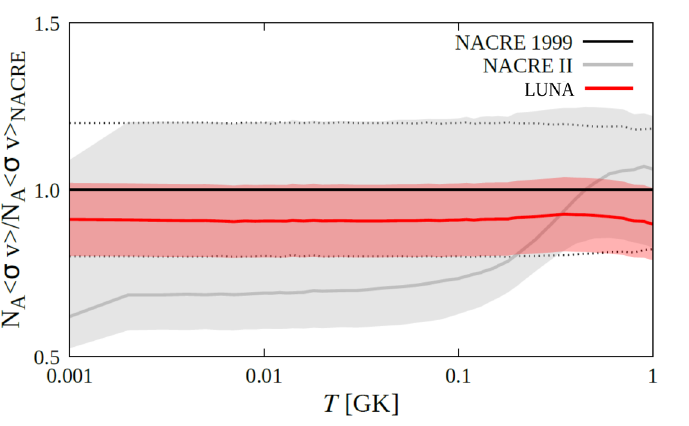
Figure 3: Reaction rate for the 6 Li( p , γ ) 7 Be reaction, normalized to the NACRE rate [24]. The NACRE II rate [16] is also shown for comparison. Dashed lines represent the uncertainty on the NACRE rate, while shaded areas represent the uncertainties from LUNA experiment (red) and from NACRE II